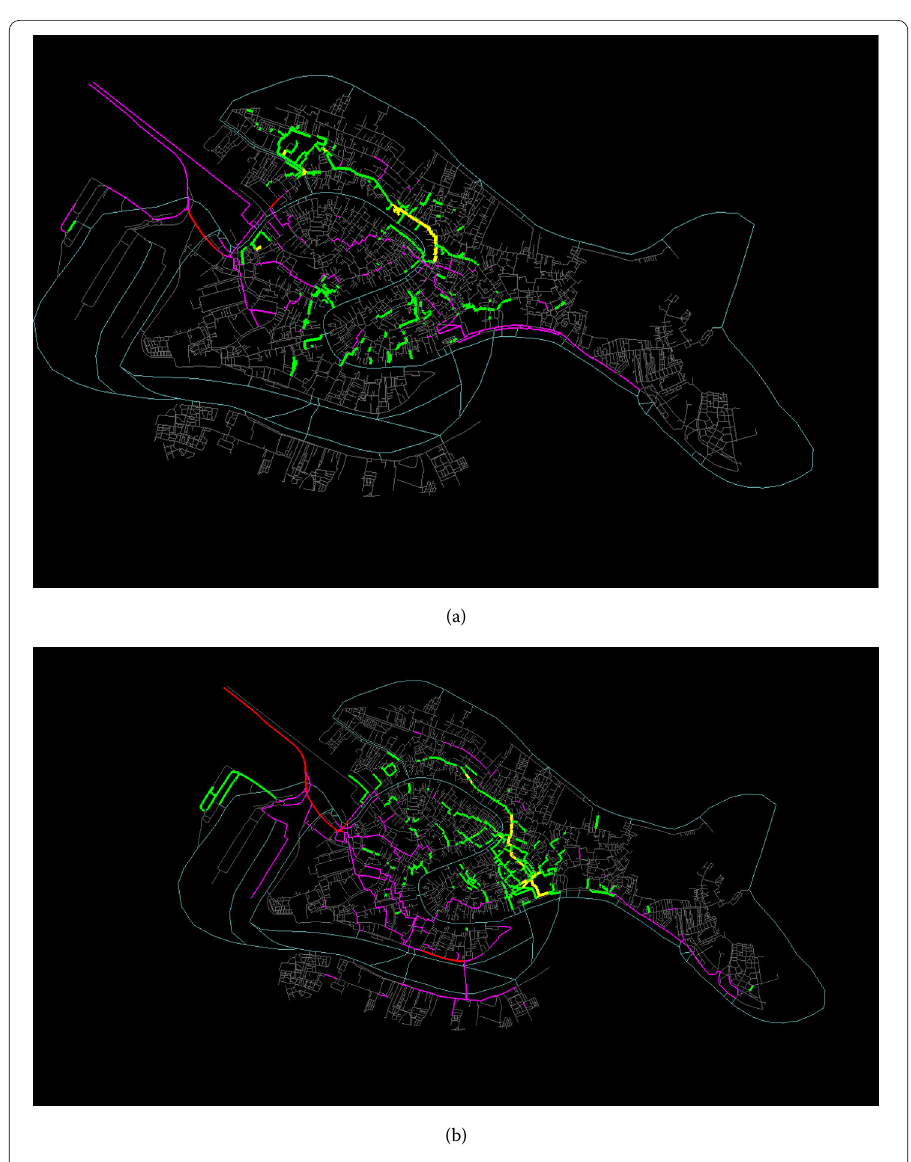
Figure 9 Preferred roads of foreigners and Italians in the historical centre of Venice during 26/02/2017 (a) and during 15/07/2017 (b). The disaggregation has been performed according to the roaming protocol in the dataset. The roads that have been found more favorite by the foreigners are highlighted in yellow and green according to the thresholds 1 and 4.5 rms in the weight difference w s – w i , whereas the more favorite roads by Italians are highlighted in red and blue according to the thresholds –1 and –4.5